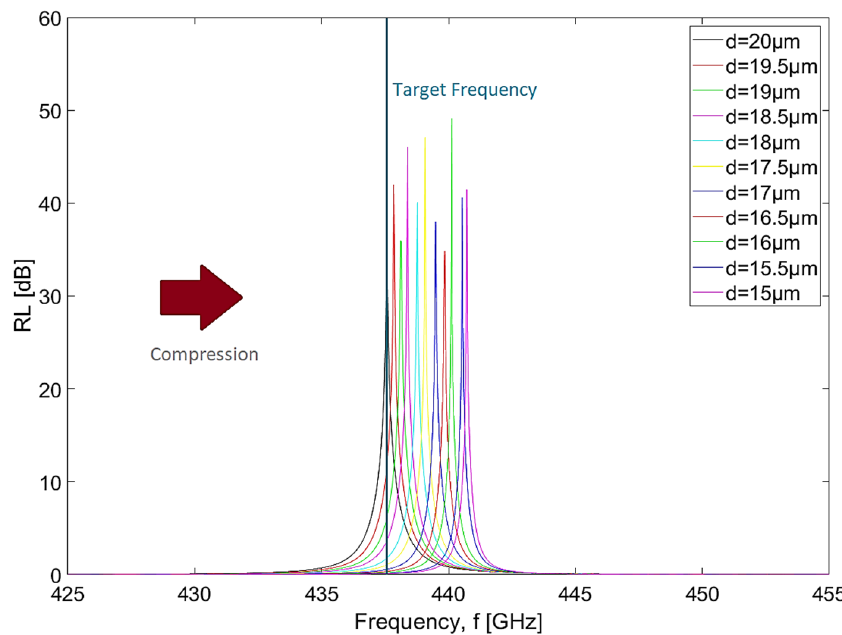
Figure 7. Return loss in the frequency domain as a function of applied compression for polytetrafluoroethylene (PTFE) host medium. Photonics 2020 , 7 , x FOR PEER REVIEW